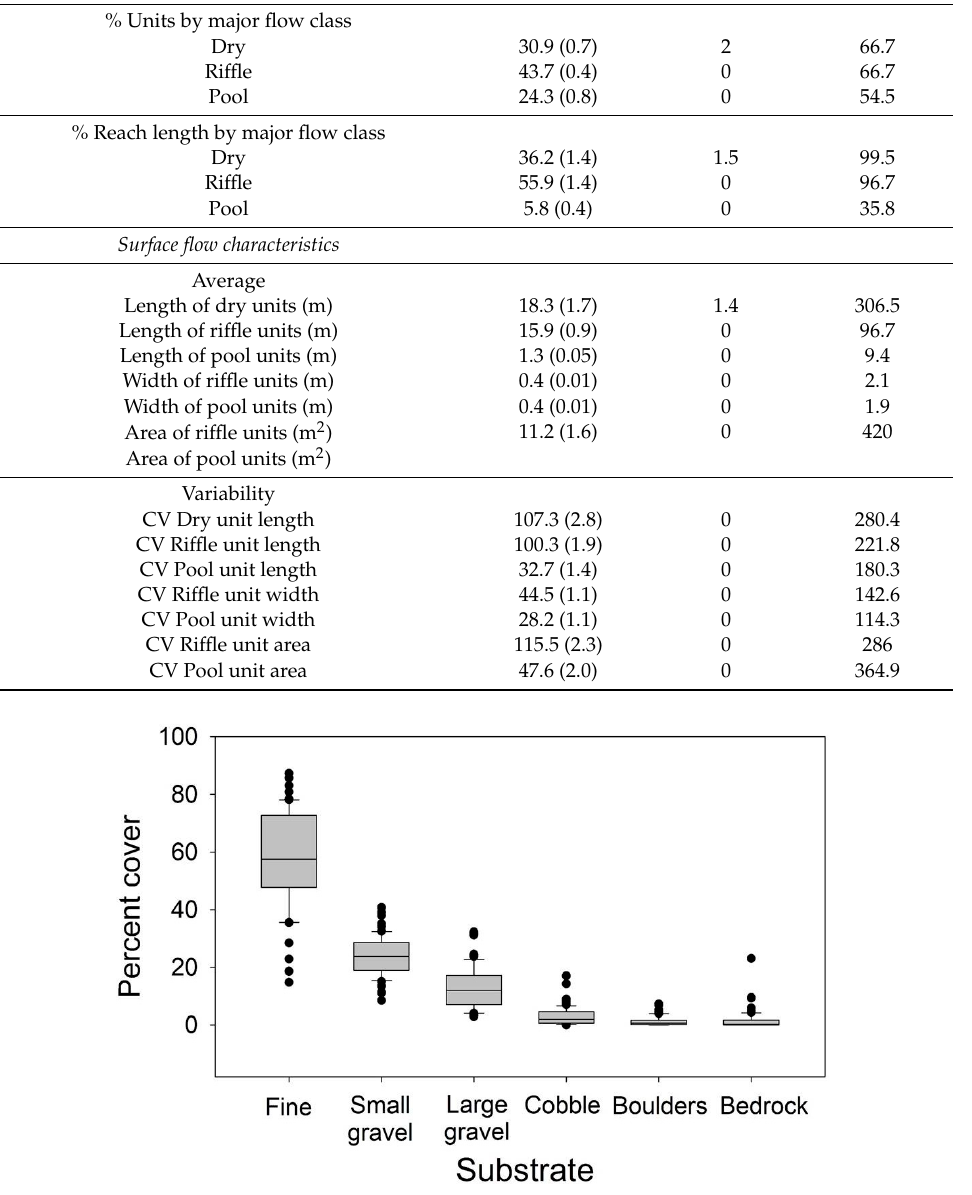
Figure 2. Box plots of substrate category distribution across the 65 study reaches.